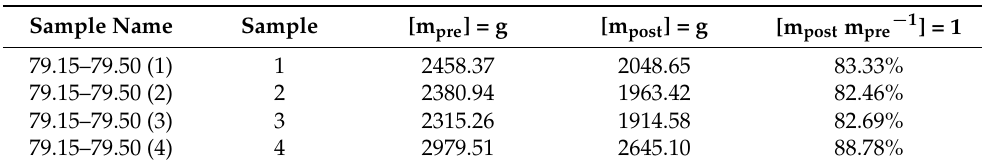
Table 5. Sample mass before (m pre ) and after (m post ) the dilatometer experiment at room temperature for 4 moist samples from 79 m-depth of drill cores.